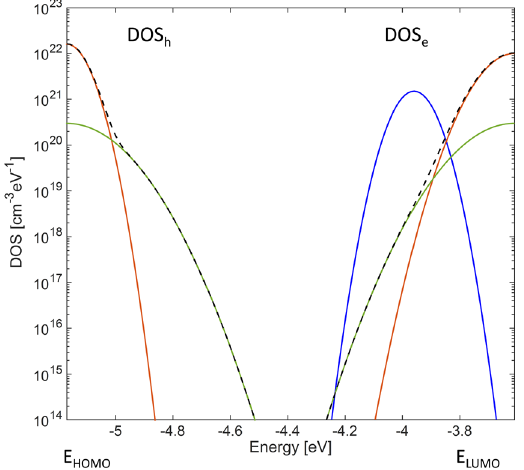
Figure 4. Electron and hole density of states. The dashed line is the overall DOS approximated by the sum of two Gaussian functions. The tail (red line) and deep (green line) states are also shown. The electron DOS parameters are the following. Total density of LUMO tail and deep states are N te = 2 × 10 21 cm − 3 and N de = 1 × 10 20 cm − 3 , respectively. The energy width of the LUMO tail and deep states are σ te = 80 meV and σ = 120 meV, respectively. The hole DOS parameters are the following. Total density of HOMO tail and deep de states are N th = 2 × 10 21 cm − 3 and N dh = 1 × 10 20 cm − 3 , respectively. The energy width of the HOMO tail and deep states are σ th = 60 meV and σ dh = 120 meV, respectively. An additional Gaussian distribution of trap states (full blue line) describes the oxygen-induced. The Gaussian distribution is located at 0.35 eV below the LUMO level, with a total density of states N tO2 = 2 × 10 20 cm − 3 and a disorder energy width σ tO2 = 50 meV. The other simulation parameters are provided in the Methods